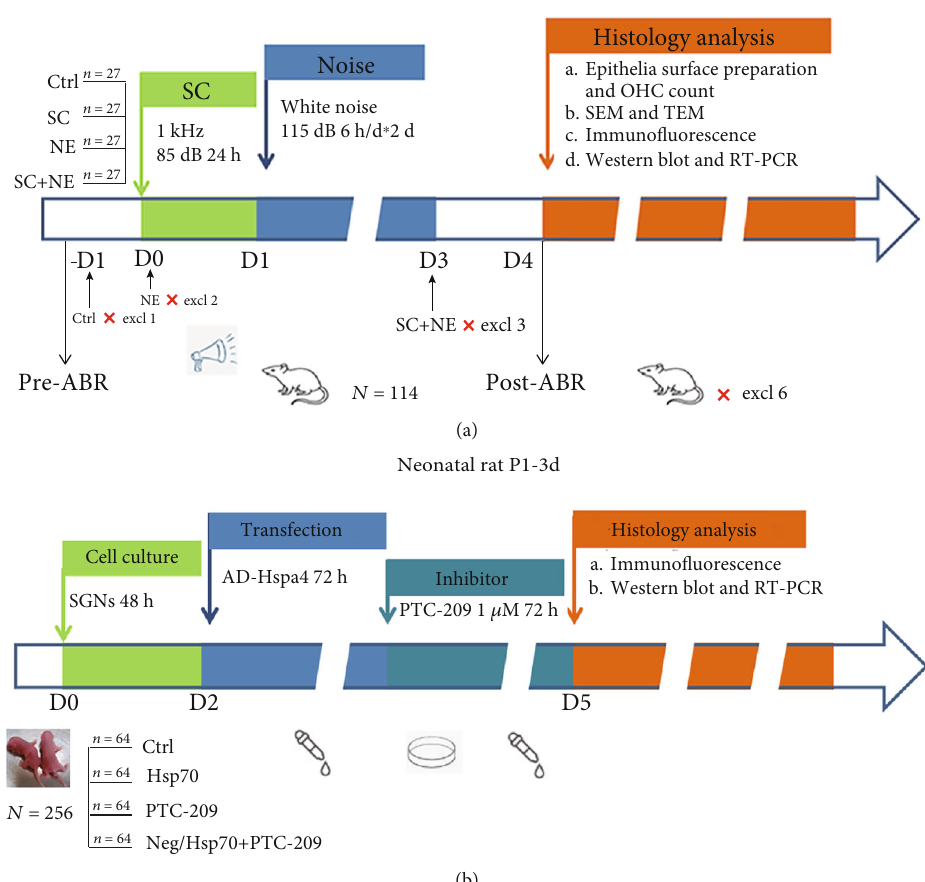
Figure 1: Chronogram of the experiment in vivo (a) and in vitro (b). (a) 114 rats were available in the experiment in vivo, but there were six animals that were excluded based on the exclusion criteria (tympanitis) or died during experiments. Rats were exposed to a pure tone of 1kHz at 85 dB SPL (SC) for 24 hours; then, some of them and others were exposed to white noise at 115dB SPL (NE) for 6 hours per day over two consecutive days with anesthesia; they were allowed to rest for 3 hours between SC and NE with anesthesia. Hearing was evaluated with auditory brainstem responses (ABRs) before 1 day prior to exposure and 1 day after exposure. At the end of the study in vivo, cochleae were dissected and processed for histology analysis. (b) The spiral ganglion neuron cells (SGNs) from 256 neonatal rats were harvested and then cultured on culture dishes for 48h; next, AD-Hspa4 (Hsp70-overexpressing adenovirus) and 1 μ M PTC-209 (a small-molecule inhibitor of Bmi1) were, respectively, added to the appropriate cells and incubated for 72 hours at 37 ° C. At the end of the study in vitro, SGNs were processed for histology